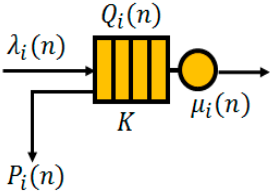
Figure 2. A queue model of underwater cellular wireless networks (UCWNs).